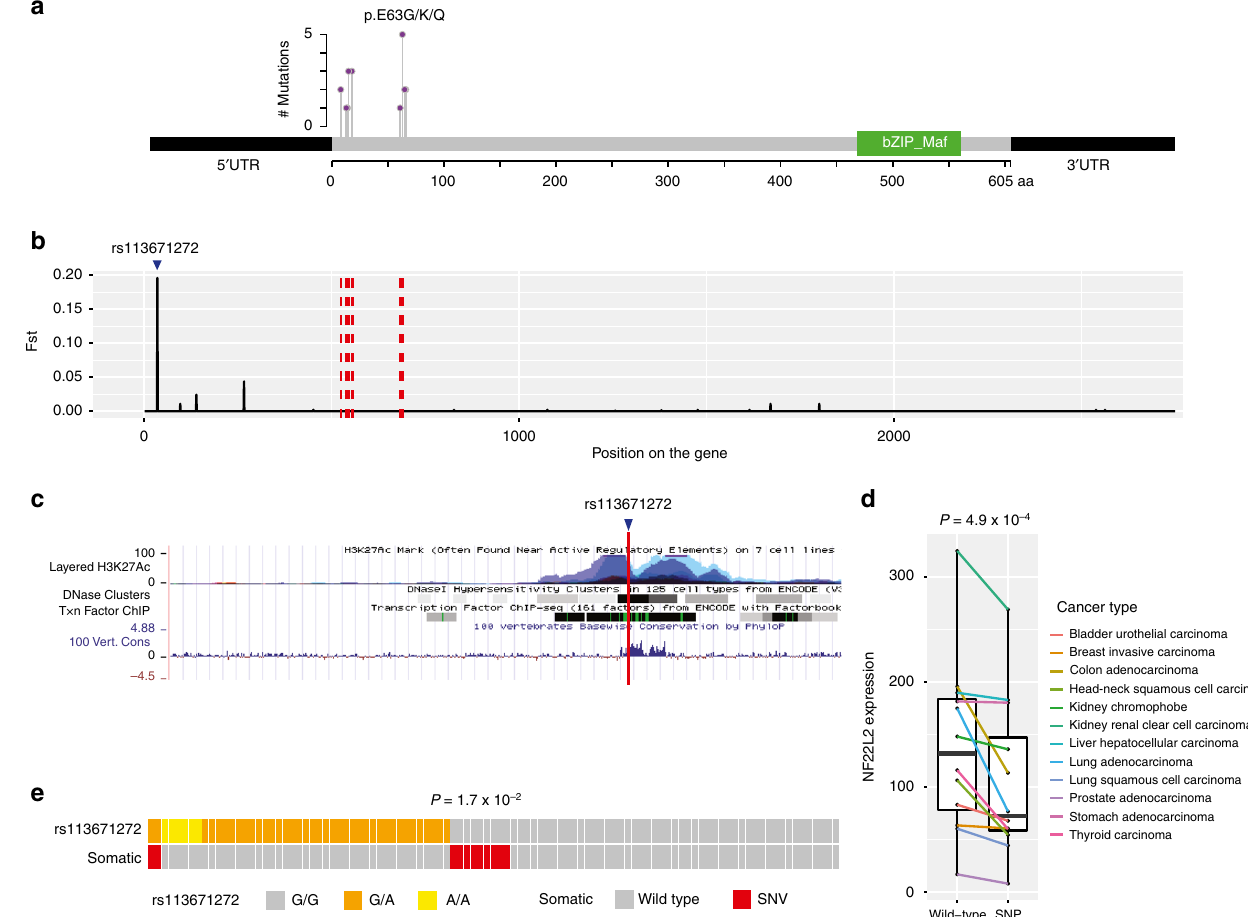
Fig. 5 Correlation of NFE2L2 mutations with a nearby high- F st SNP in Asian patients. a Mutational distribution on NFE2L2 from all the WES samples. There are two major mutational hotspots. b F st-index values of the SNPs on the exonic regions of NFE2L2 , among which rs113671272, located in 5 ′ UTR, shows the highest F st index in the comparison between southern Han Chinese and European. c The gene regulation tracks from the UCSC genome browser show that rs113671272 is located within a region with high-density regulatory binding sites and high conservation scores. d The effect of the SNP rs113671272 on the mRNA expression level of NFE2L2 across 12 TCGA cancer types. After excluding tumor samples with somatic mutations in NFE2L2 , the cancer types with at least three samples in the SNP-containing group were included in the analysis. The expression levels between the sample groups (with or without the SNP) across cancer types were compared with paired Wilcoxon signed-rank test. e Mutual exclusivity pattern of rs113671272 SNP and the somatic mutation status in the Asian WES samples with suf fi cient coverage. P -value was calculated by CoMEt